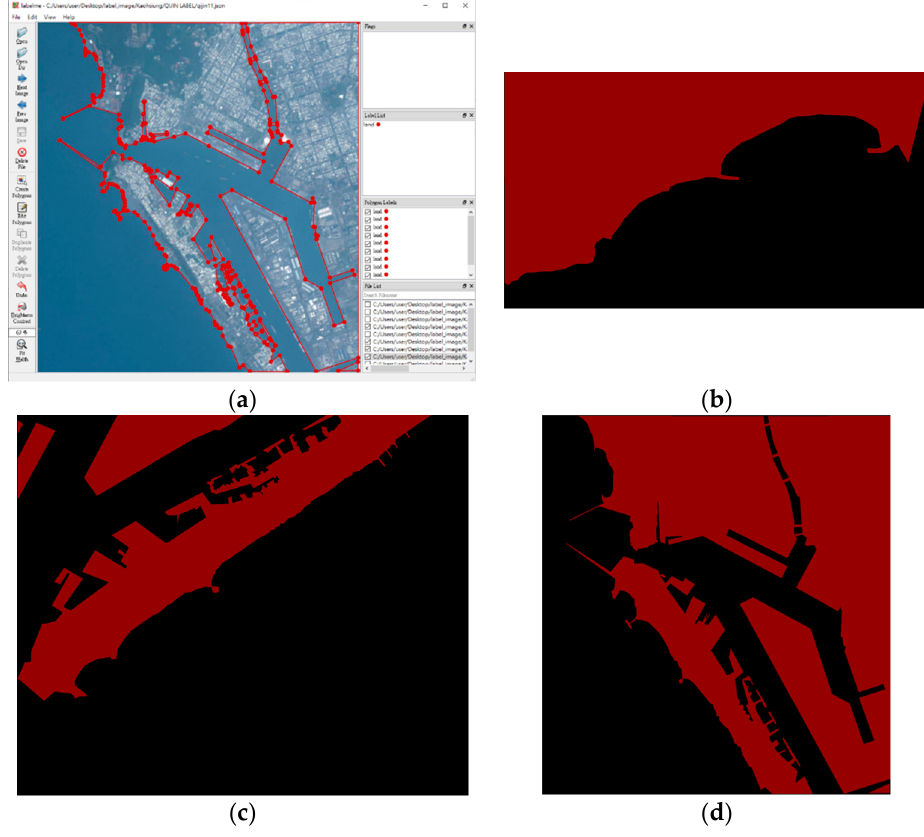
Figure 9. Labeling process and results of Kaohsiung Port: ( a ) LabelMe interface; ( b ) Near scale; ( c ) Medium scale; ( d ) Far scale.